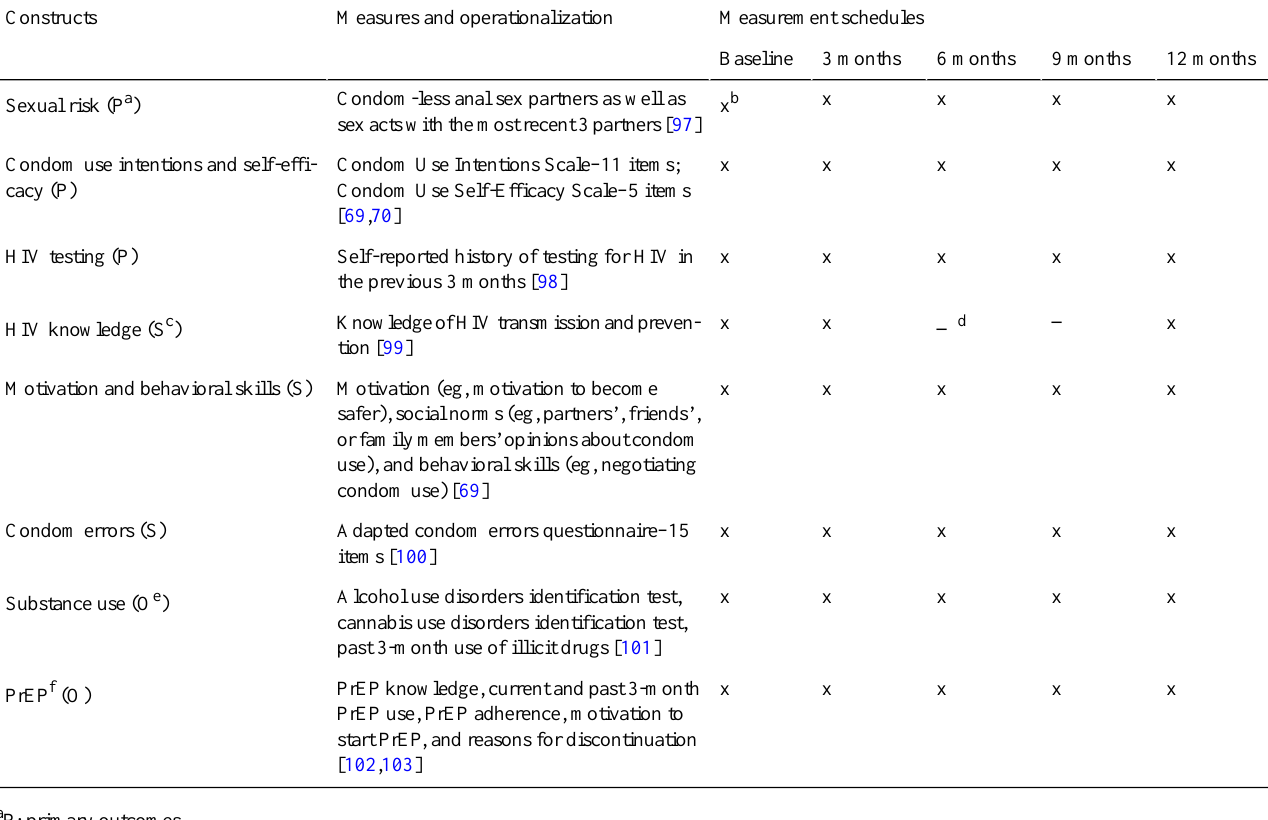
Table 1. Primary, secondary, and other outcome measures: operationalization and schedule.